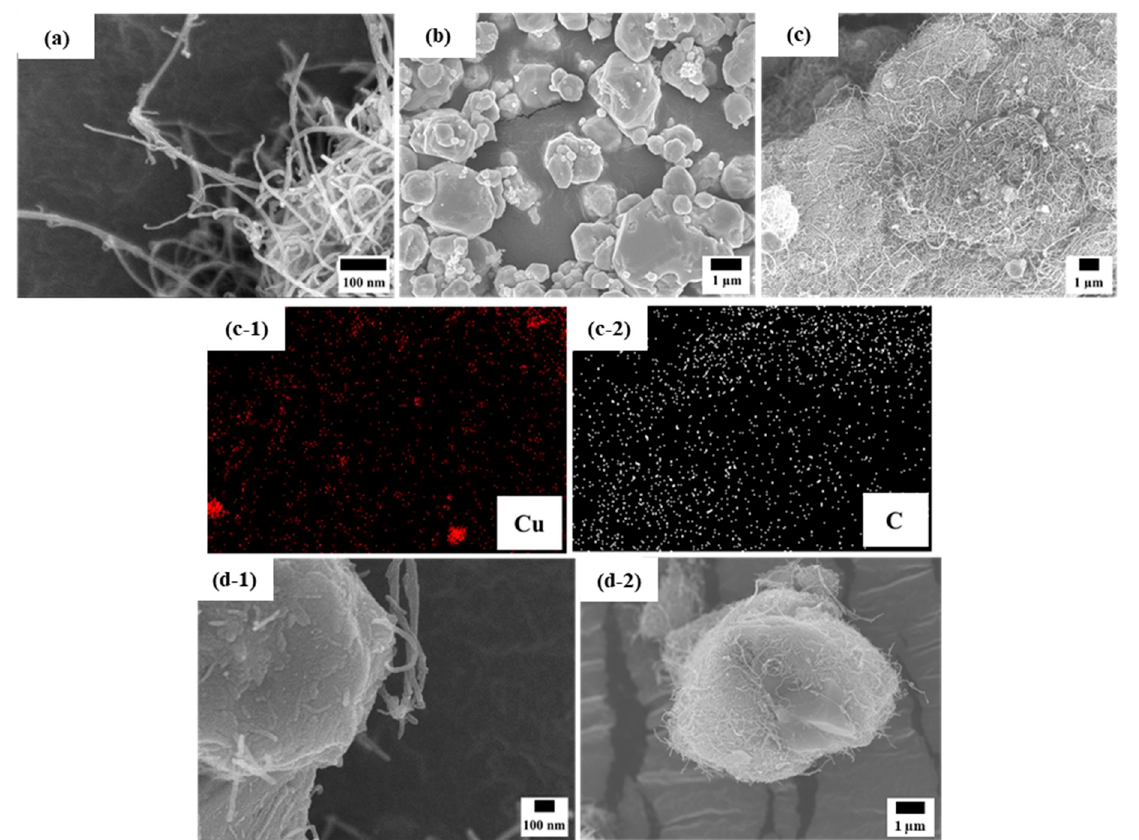
Figure 2. FE-SEM images of ( a ) initial MWCNTs, ( b ) initial Cu powder, ( c ) ball-milled hybrid powder and its corresponding EDS map ( c-1 , c-2 ), and ( d-1 , d-2 ) magnified images of the ball-milled hybrid powder wherein MWCNTs are partially embedded into Cu